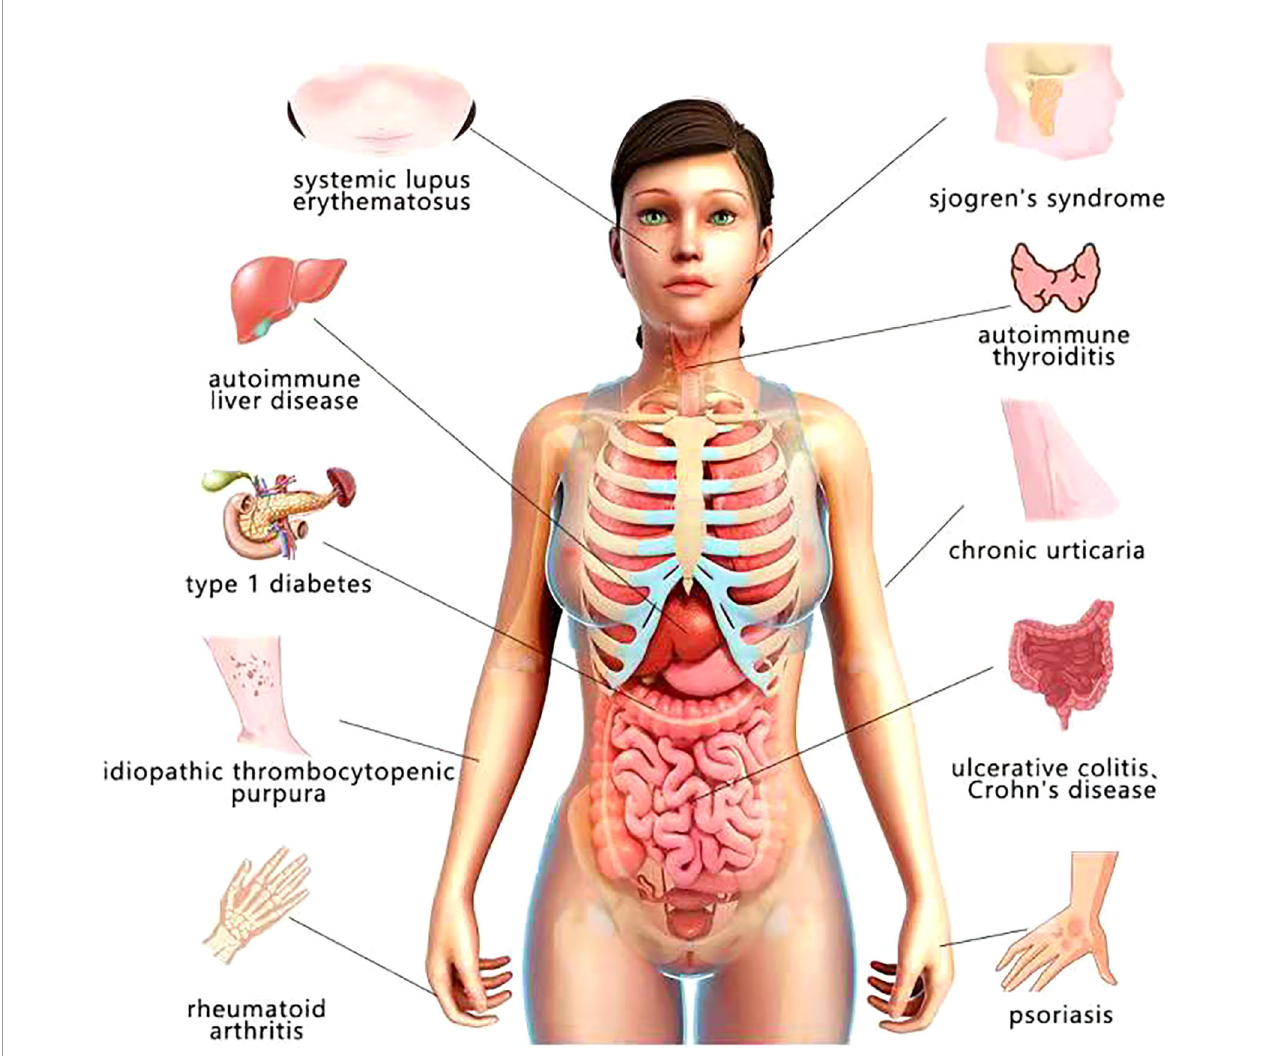
FIGURE 2 | Autoimmune diseases which are likely to have relationship with H. pylori